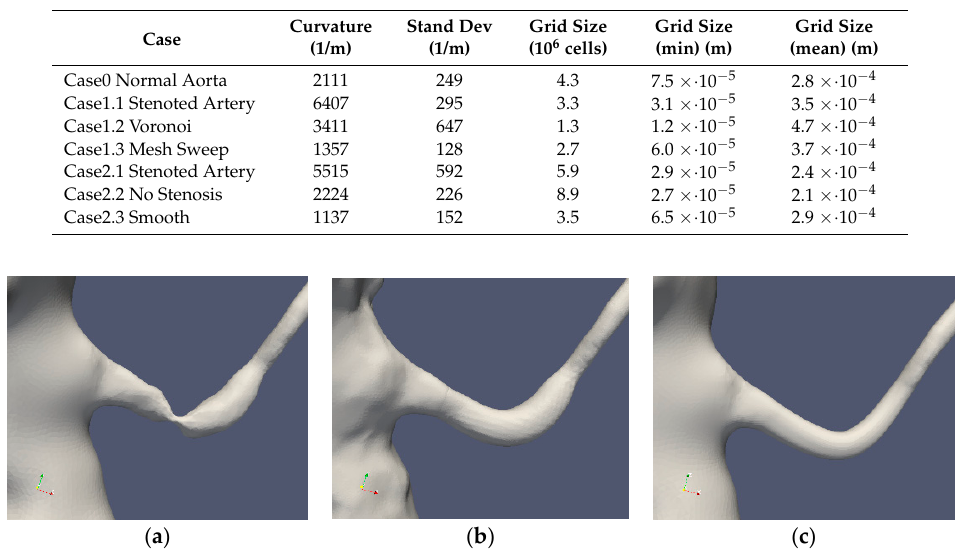
Figure 2. Case1 segmentations: original ( a ), Voronoi ( b ) and mesh sweeped and smoothed ( c ).